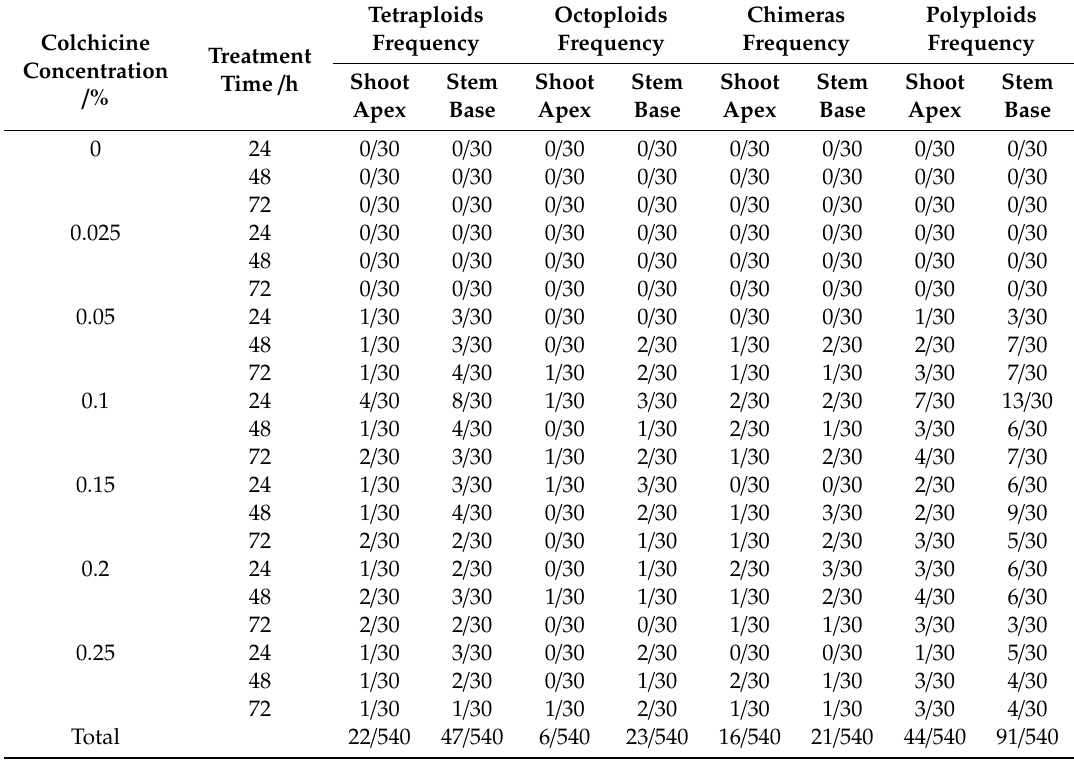
Table 2. Comparison of the number of polyploid induction from di ff erent colchicine treatments.